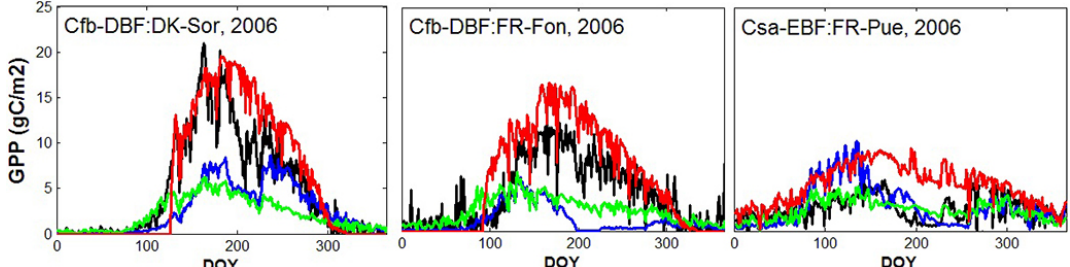
Figure 6. Example of annual cycle of the daily GPP for three forest sites (DK-Sor, FR-Fon and FR-Pue) in 2006. ISBA-A-gs simulation is in blue, CTESSEL in green and ORCHIDEE in red, while black line represents EC measured data.